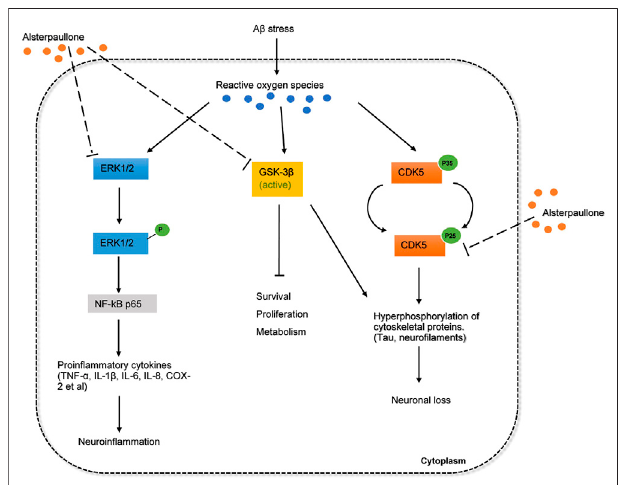
FIGURE 3 | The inferred mechanism of alterpaullone in AD pathology. The drug acts through the inhibition of GSK3 β , CDK5, and ERK1/2. The inhibitionofGSK3 β andCDK5leadstoreducedhyperphosphorylationoftoxic cytoskeletal proteins and promote cell survival and proliferation. The inhibition of ERK1/2 leads to deactivation of NF-kB p65 that produces proin fl ammatory cytokines during in fl ammation. The solid dash lines show the interactions of protein kinases and signaling cascades. The long-dashed lines show the pharmacological action of